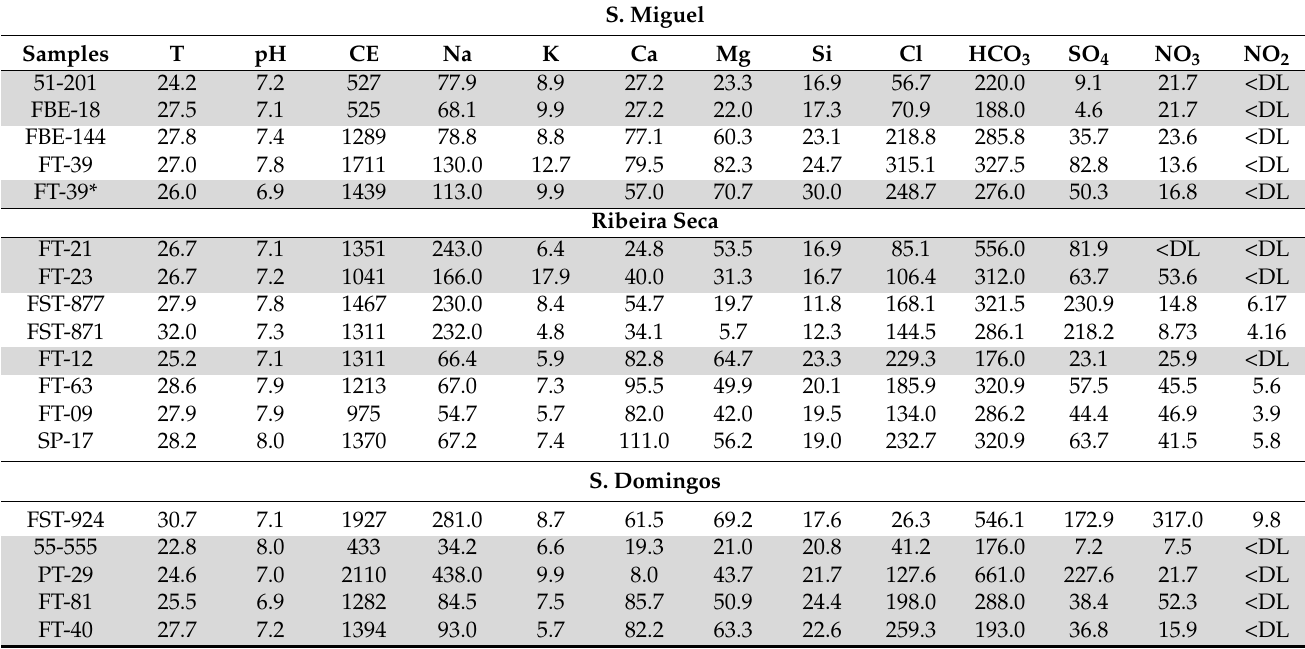
Table 3. Hydrochemistry in the most cultivated sub-basins of Santa Cruz river basin: T in ◦ C; EC in µ S/cm; ions in mg/L; DL—detection limit of the analytical method. Rows in gray are from [29]; the others were obtained in the summer of 2016 (present